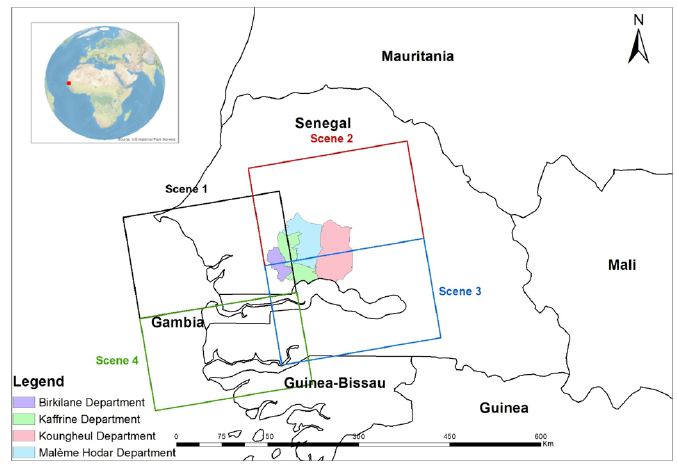
Figure 1. Map of the study area in the Kaffrine region with its four departments.